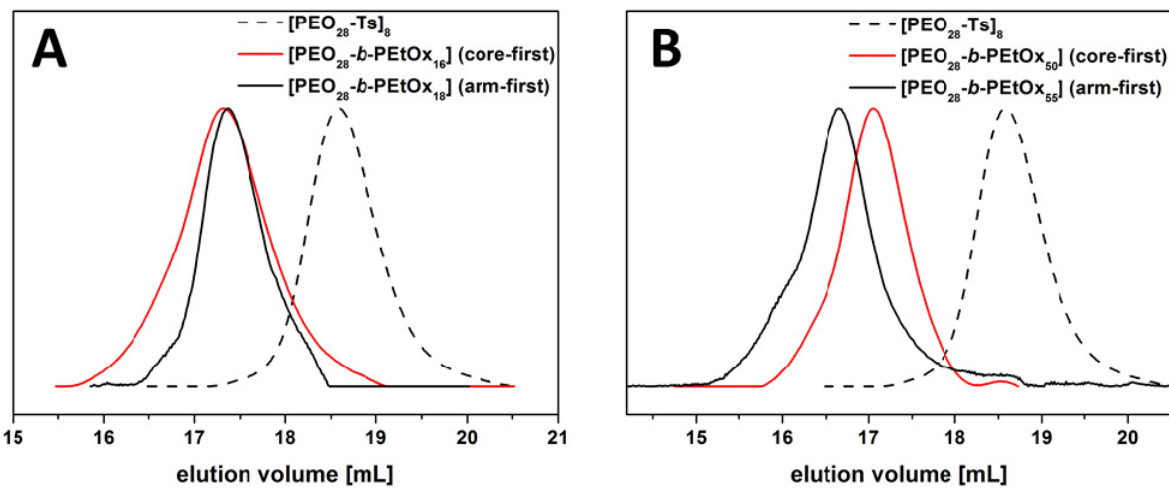
Figure 5. Comparison of the SEC traces obtained via the “core-first” (solid red lines) and -Ts] (dashed line) for the “arm-first” approach (solid black lines) in comparison to [PEO 28 8 - b -PEtOx ] (core-first; red curve) and [PEO - b -PEtOx ] two compositions: ( A ) [PEO 28 16 8 28 18 8 (arm-first; black curve); and ( B ) [PEO - b -PEtOx ] (core-first; red curve) and 28 50 8 [PEO - b -PEtOx ] (arm-first; black 28 55 8